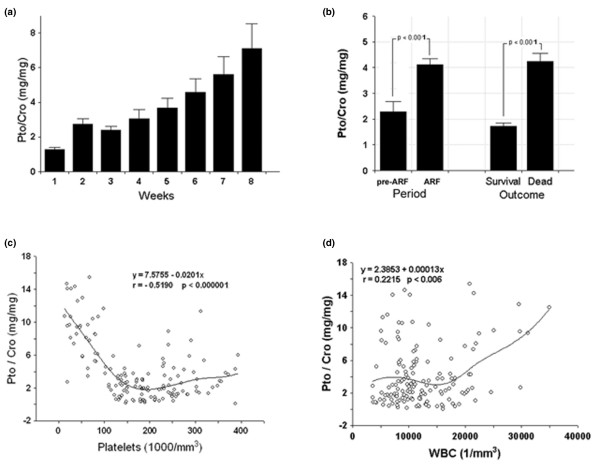
Proteinuria correlates with patient outcome and with markers of systemic inflammation. (a) Proteinuria expressed as proteinuria/creatininuria ratio (Pto/Cro, mg/mg) in the weeks following patient admission. Data are given as weekly average of daily values. Only non-oliguric patients were included and the number of patients for each week was: week 1, n = 19; week 2, n = 19; week 3, n = 17; week 4, n = 15; week 5, n = 10; week 6, n = 7; week 7, n = 6; week 8, n = 5. (b) Overall mean proteinuria in pre-acute renal failure (ARF) vs ARF periods and in deceased vs surviving patients. (c, d) Relationship between Pto/Cro and indexes of systemic inflammatory state in ARF period. Pto/Cro negatively correlated with platelet count (c) and positively with white blood cell (WBC) count (d). Student t test and linear regression analysis were performed where appropriate. Data for different parameters are also shown as minimal square fitting curves.